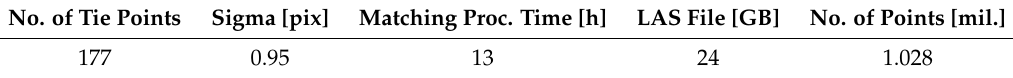
Table A1. Image orientation and 3D